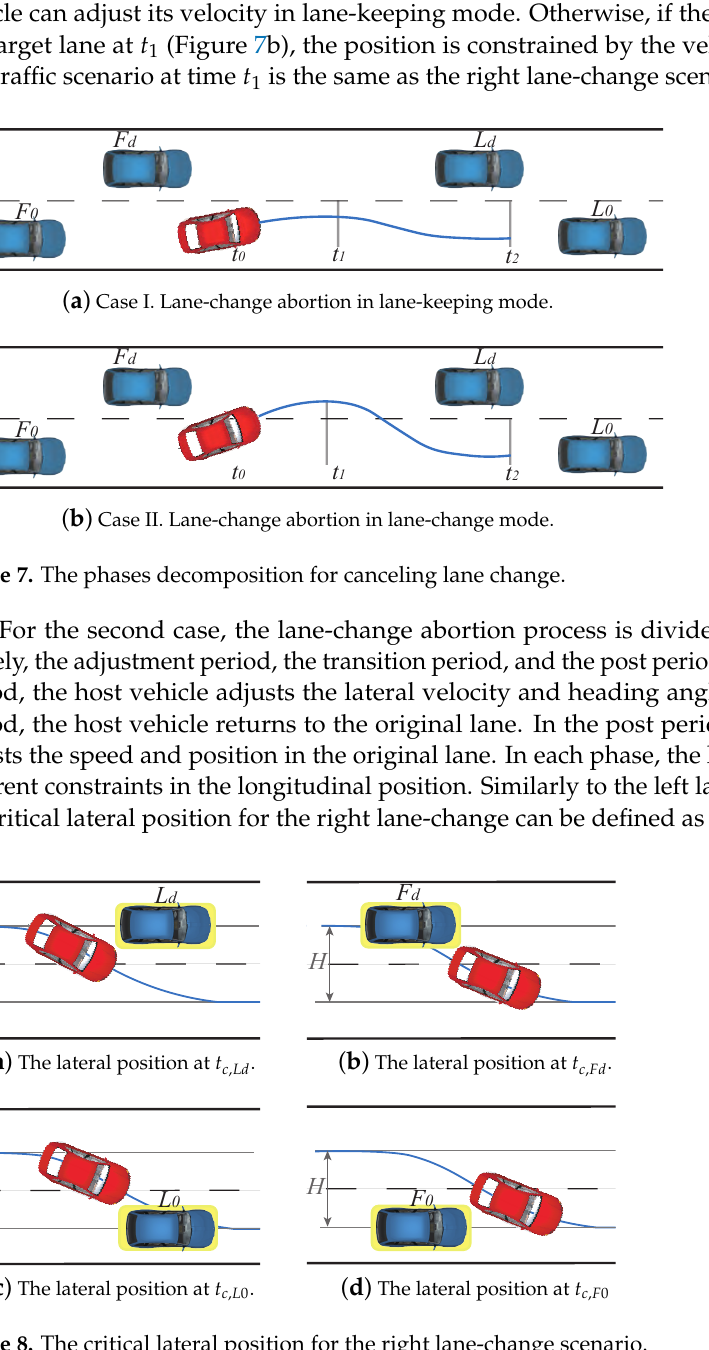
Figure 8. The critical lateral position for the right lane-change